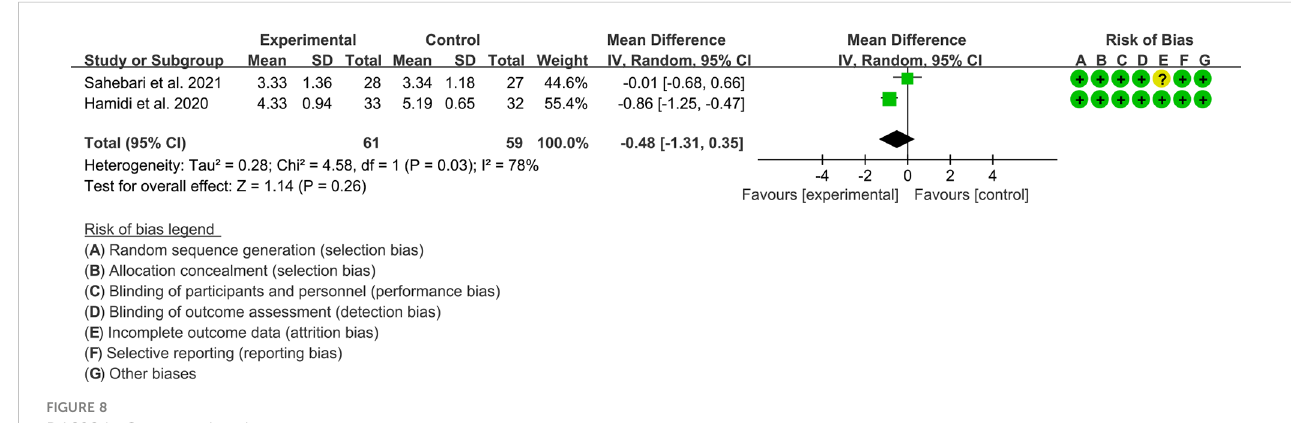
FIGURE 8 DAS28 in Crocus sativus